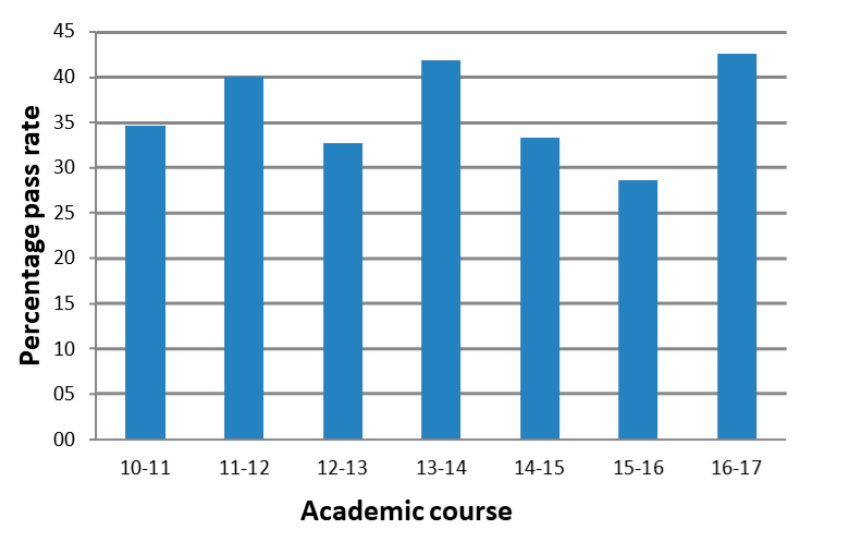
Figure 1. Percentage pass rate of students attending the